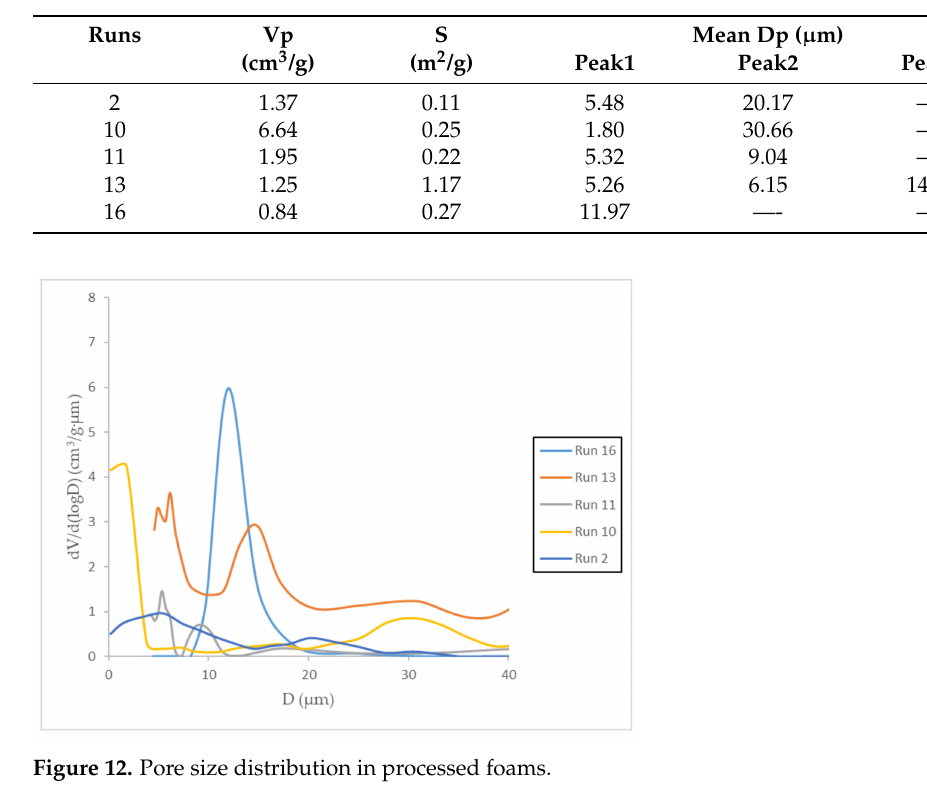
Table 3. Textural properties of the foamed polymer samples.